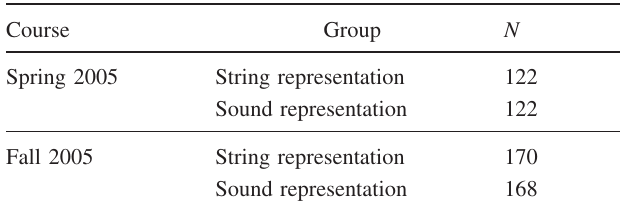
TABLE II. Two groups for the wave representation assessment (cid:1) string and sound (cid:2) for the initial (cid:1) spring (cid:2) and follow-up (cid:1) fall (cid:2) studies. Course